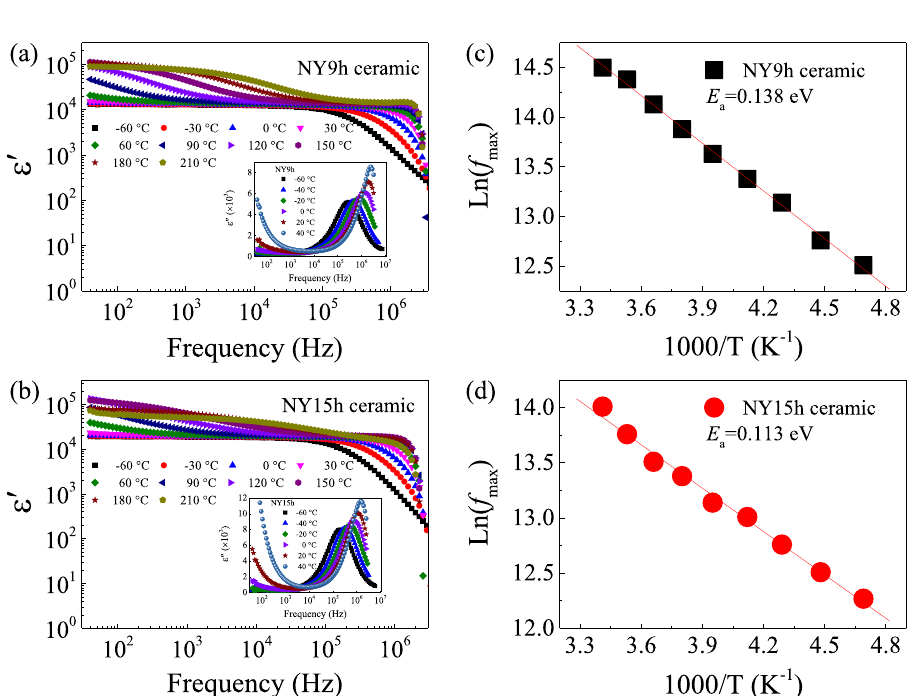
Figure 7. ( a , b ) Frequency dependencies of ε ′ at various temperatures of NY9h and NY15h ceramics, respectively. Inset of each figure discloses the frequency dependency of ε ″ . ( c , d ) Arrhenius plots of f max of these ceramic